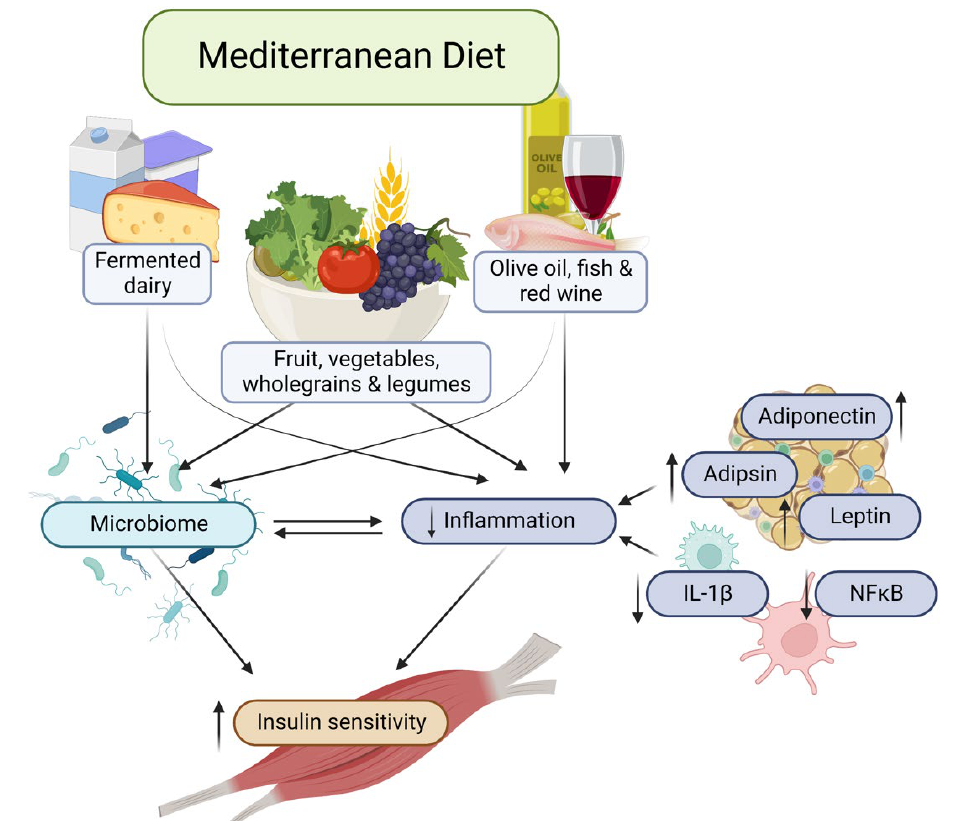
Figure 1. Principal mechanisms responsible for playing a role in protecting against insulin resistance and inflammation regulated by Mediterranean diet.